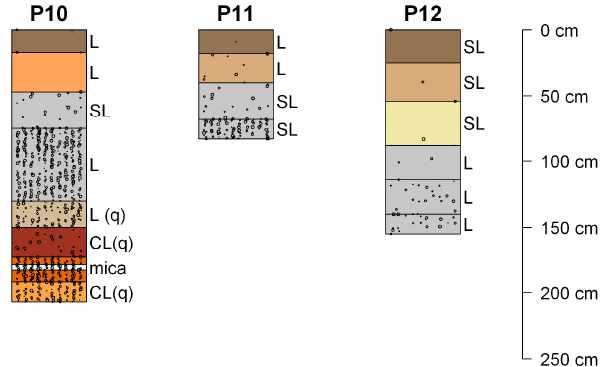
Figure 10. Soil profiles of the measuring points at the slope toe on the plots under crop production (P10), semi-natural vegetation (P11), and under bare fallow (P12), showing soil color (as qualitatively observed in the field), texture, and skeletal fraction. The soil texture of the lower four horizons at P10 was analyzed manually in the field (q). CL = clay loam, L = loam, SL = sandy loam.